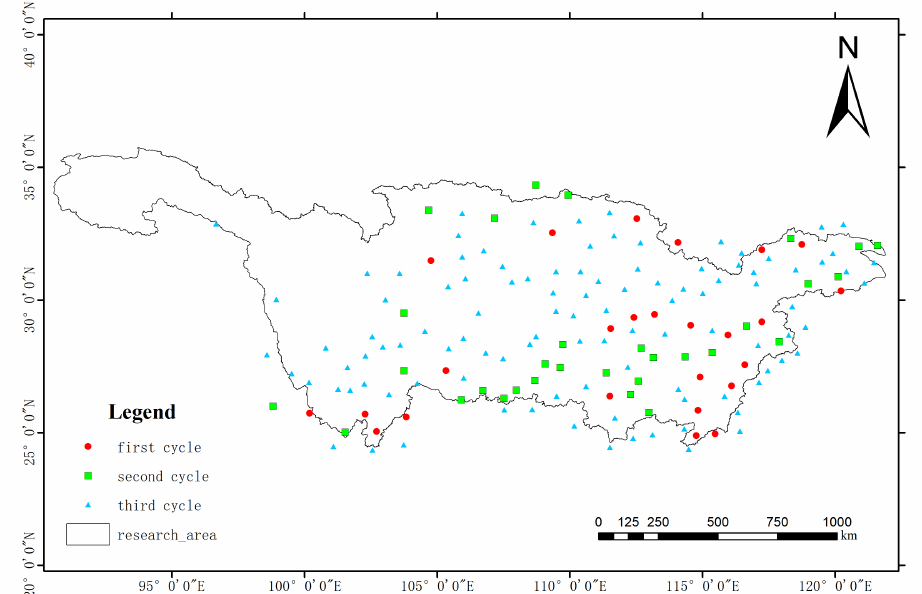
Figure 8. Distribution of stations corresponding to evaporation data meeting the first, second and third